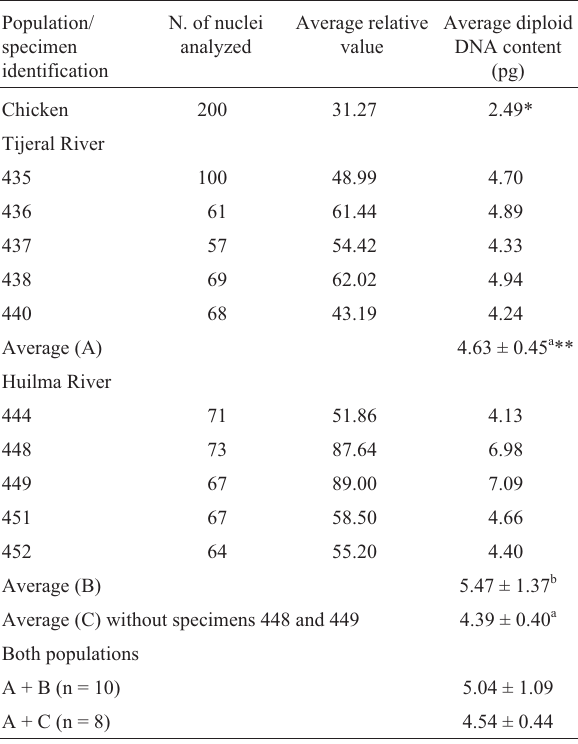
Table 2 - DNA content analysis of two populations of T. areolatus from Chile. DNA content was determined by microdensitometry of Feulgen-stained nuclei of